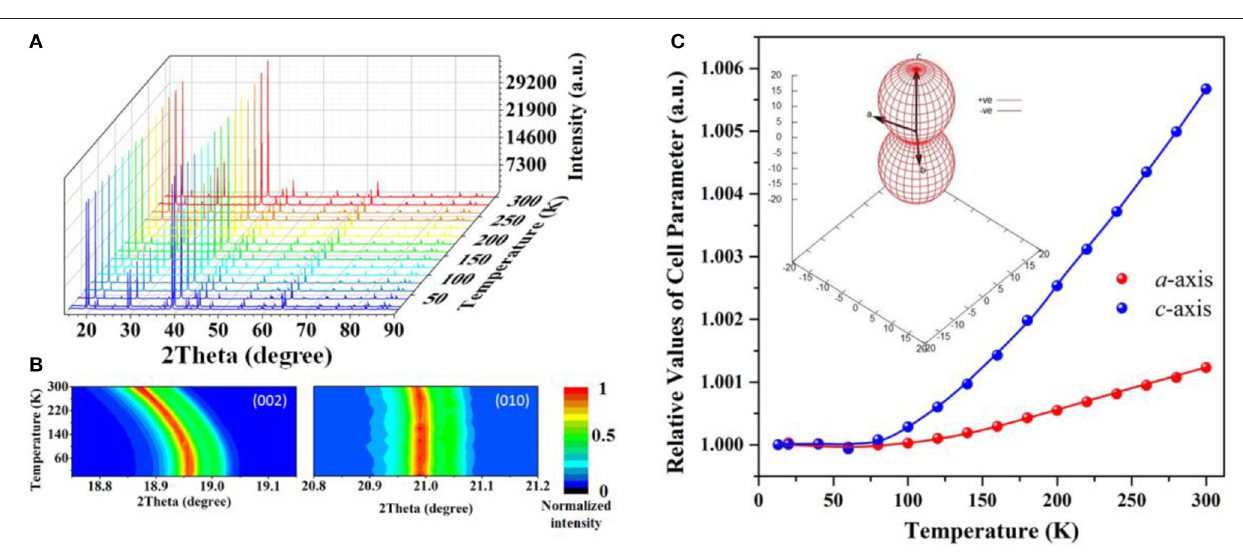
FIGURE 2 | Result of VT-XRD on BABF: (A) the VT-XRD patterns, (B) 2 θ -temperature contour map of the diffraction peak of (002) and (010) plane and (C) evolution of cell parameters with respect to temperature. The insert in (C) displays the special distribution of thermal expansion coefficient plotted by PASCal software (Cliffe and Goodwin,